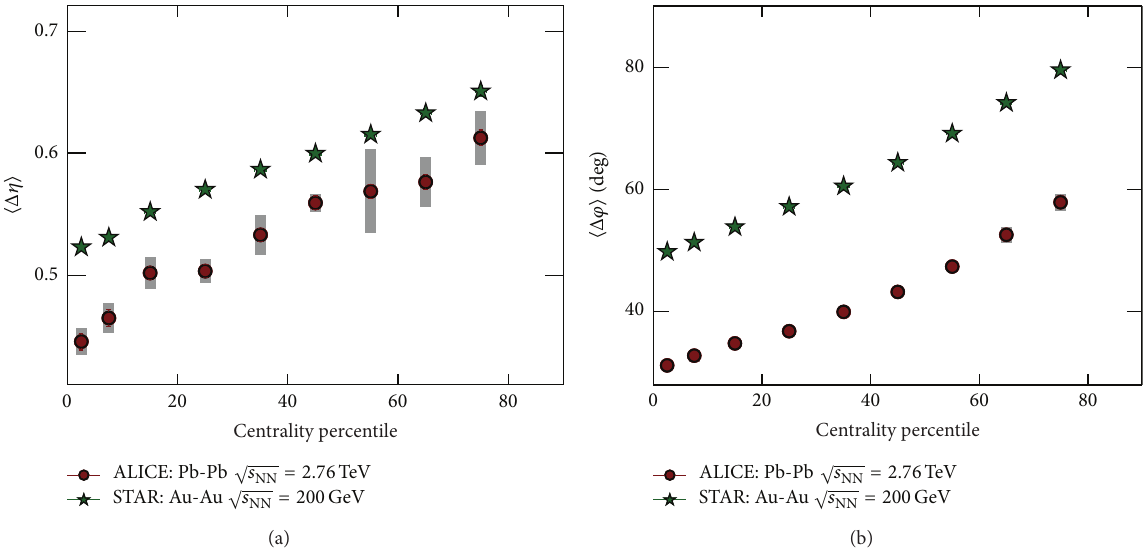
Figure 10: From ALICE and STAR experiments, the centrality dependence of the balance function width ⟨Δ𝜂⟩ (a) and ⟨Δ𝜑⟩ (b). The STAR results [35] have been corrected for the finite acceptance as suggested in [36]. The figure is taken from [37].